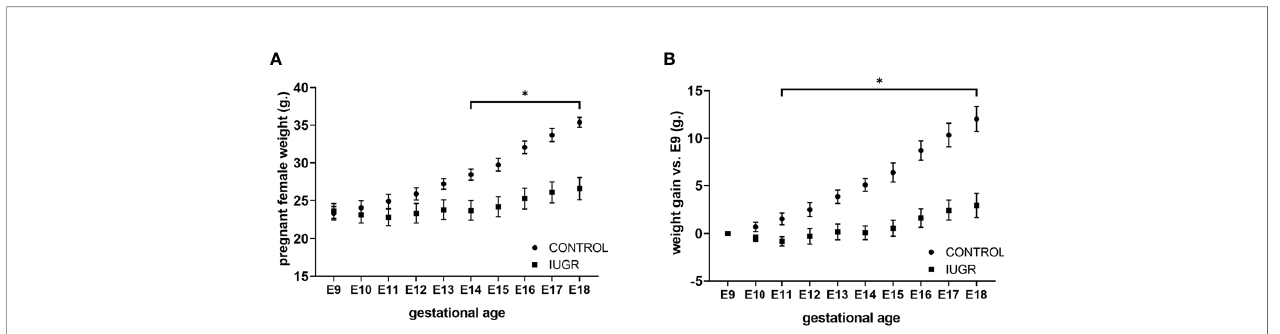
FIGURE 1 | Calorie restriction reduces female weight maternal average gain weight during pregnancy. Pregnant C57BL/6 mice (n=6 per group) exposed to 50% calorie restriction diet (IUGR) or ad-libitum (CONTROL) throughout gestation were monitored daily for (A) weight, and (B) weight gain from E9 to E18.5. * P <0.05 vs . IUGR by l-way ANOVA with time as repeated measurements, and the Dunnet Post-hoc test. Values are represented as means ±